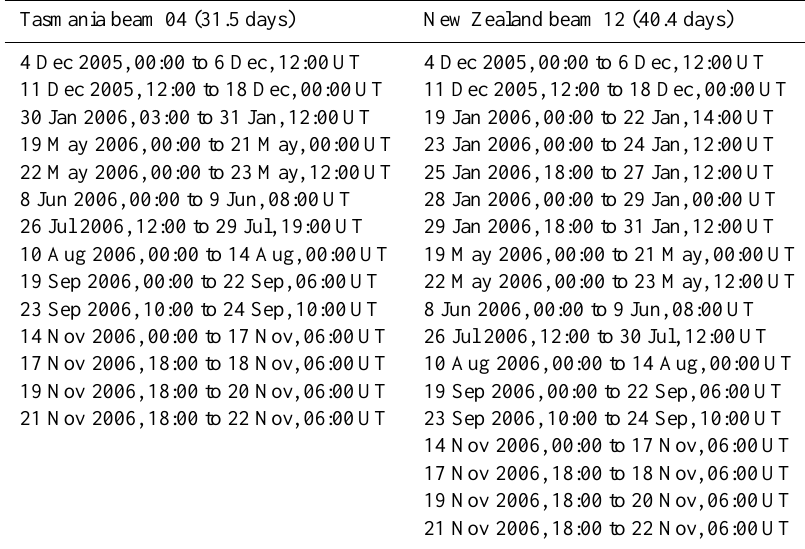
Table 1. TIGER 1-s camping beam